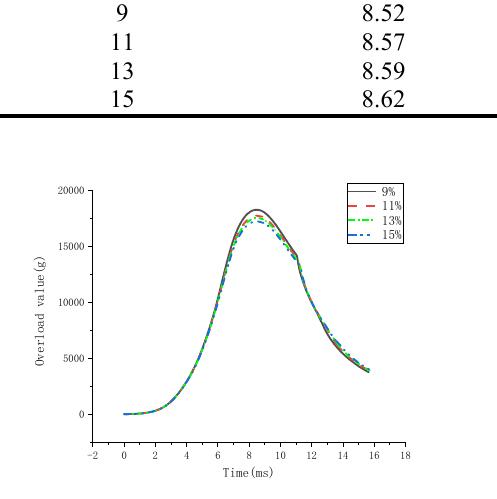
Fig. 6. a-t curves of different mass ratios of the coating layer.